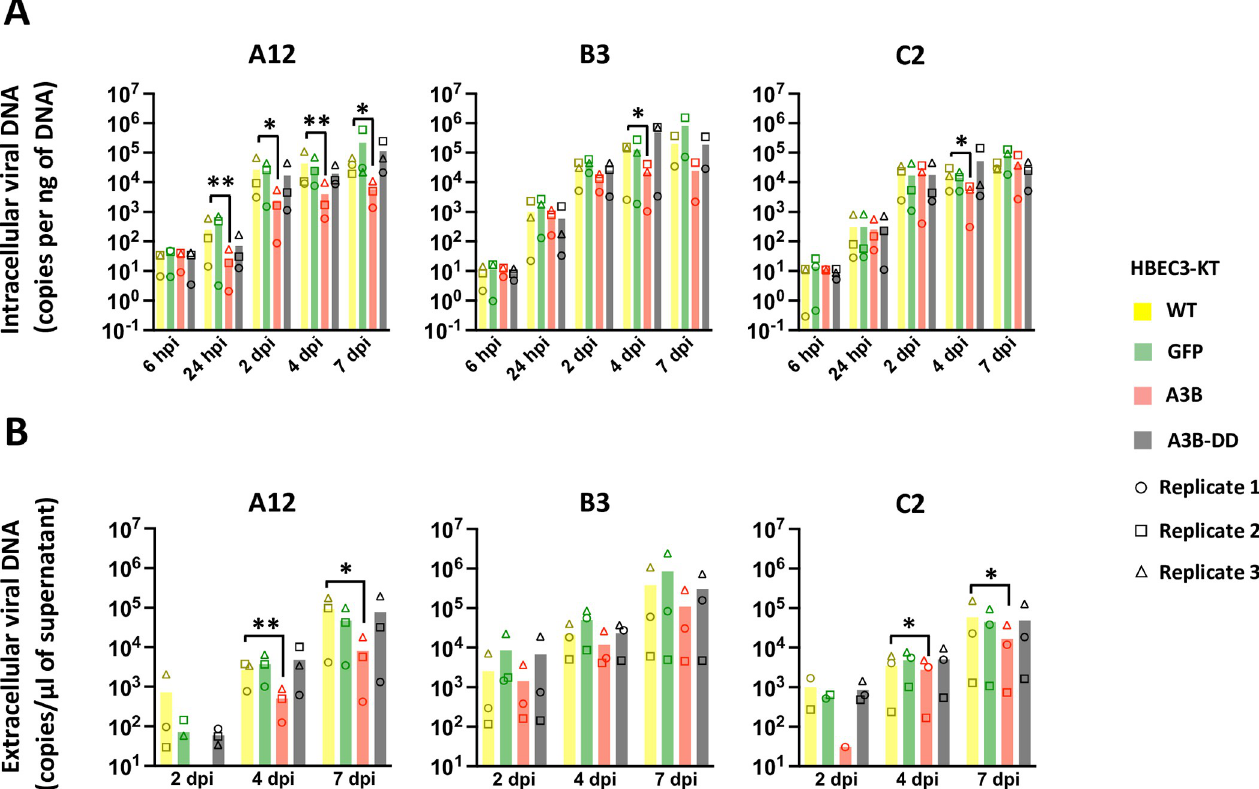
Fig 2. A3B slows down viral DNA production. HBEC-WT, -GFP, -A3B and -A3B-DD were infected with HAdV-A12, -B3 or -C2 at a MOI = 0.03. Intracellular viral DNA levels (A) and extracellular viral DNA levels (B) were quantified by qPCR at different time points post infection. P-values were calculated by ratio t-tests. Only significant differences are